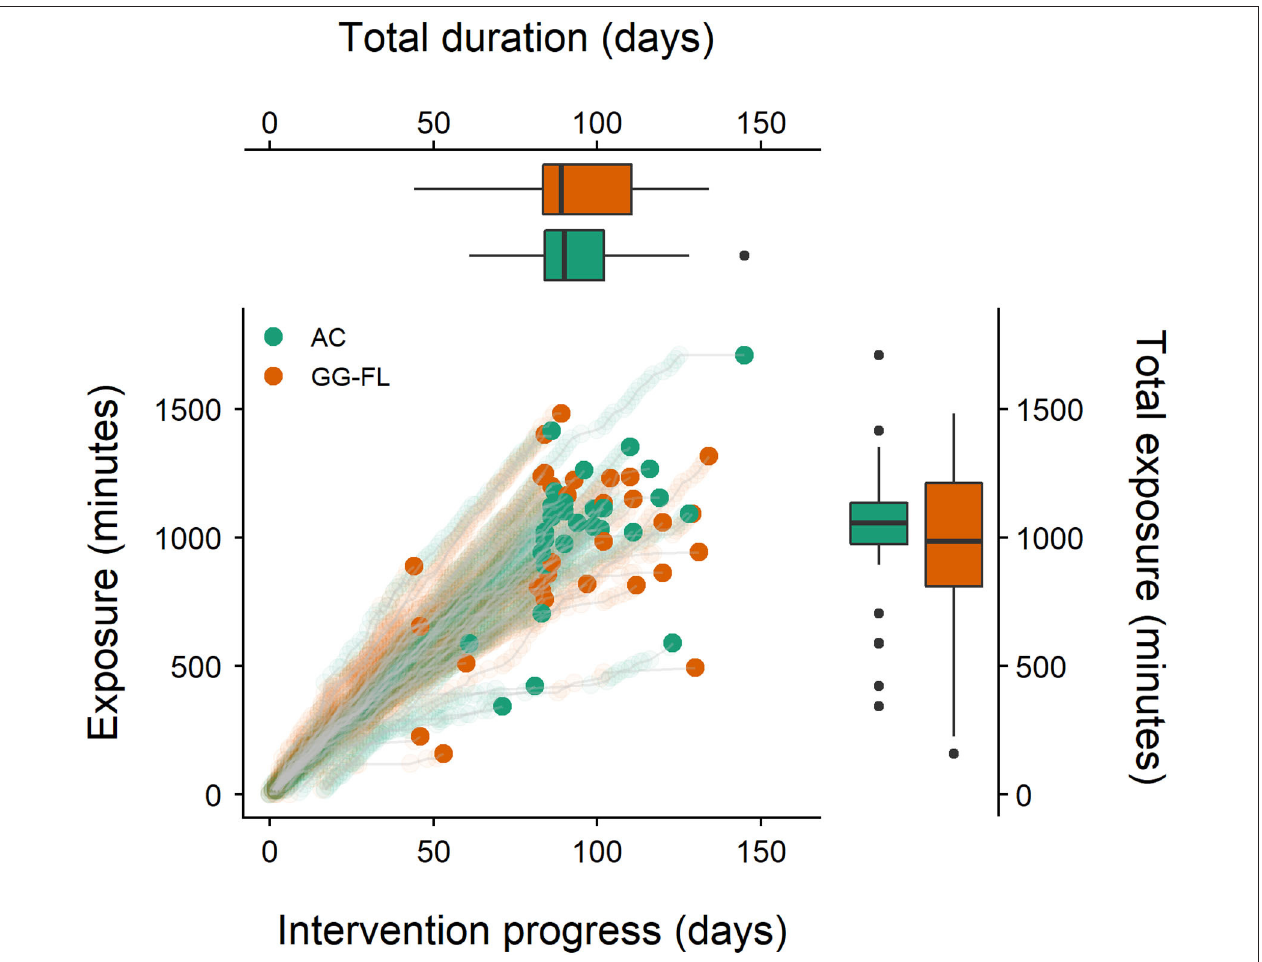
FIGURE 3 | Individual interventional AC/GG-FL trajectories and total training GG-FL/AC duration and exposure. AC, active control group; GG-FL, GraphoGame Flemish group. The bold dots represent an individual’s last GG-FL/AC playing day and highest obtained GG-FL/AC intervention exposure. Boxplots represent the overall group distributions of total GG-FL/AC exposure and total GG-FL/AC training